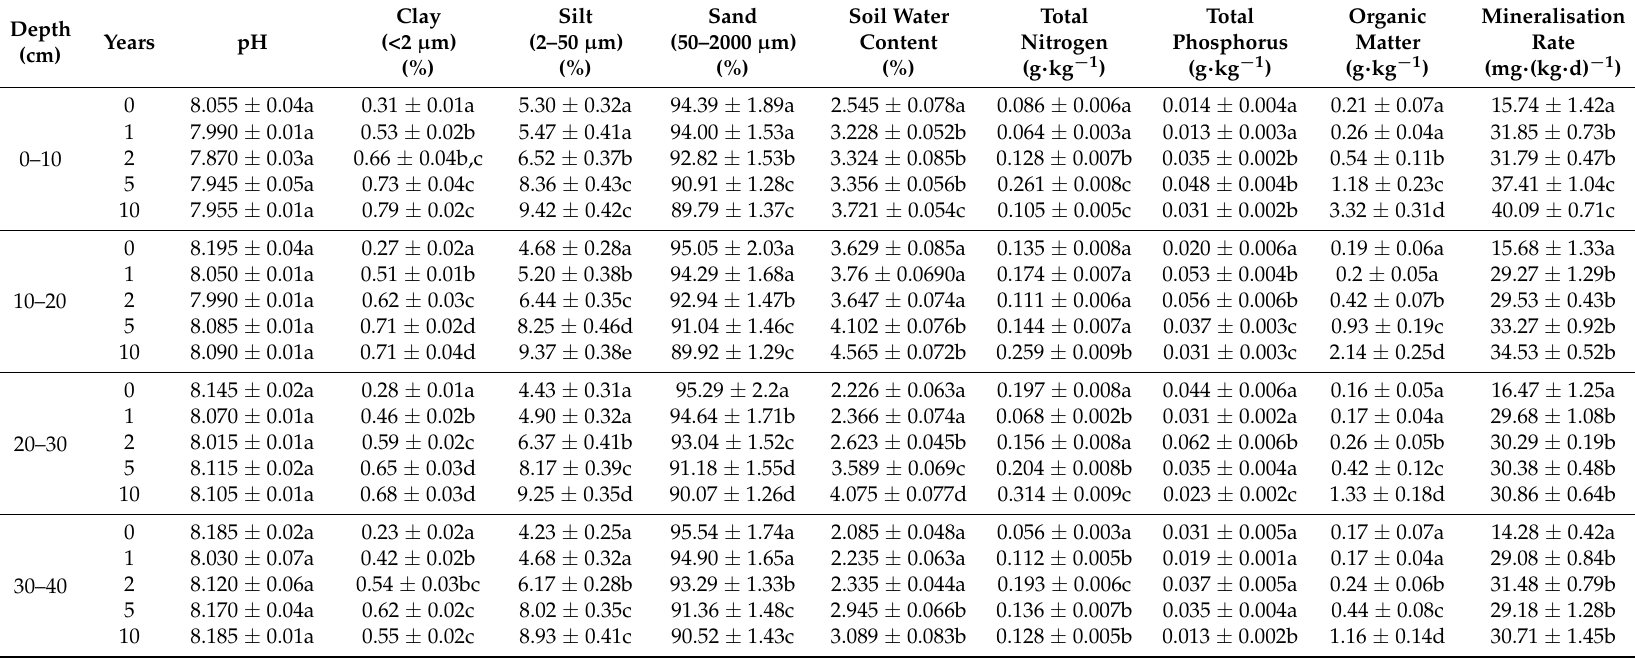
Table 2. Physical and chemical properties of soil layers in the years after a straw checkerboard was